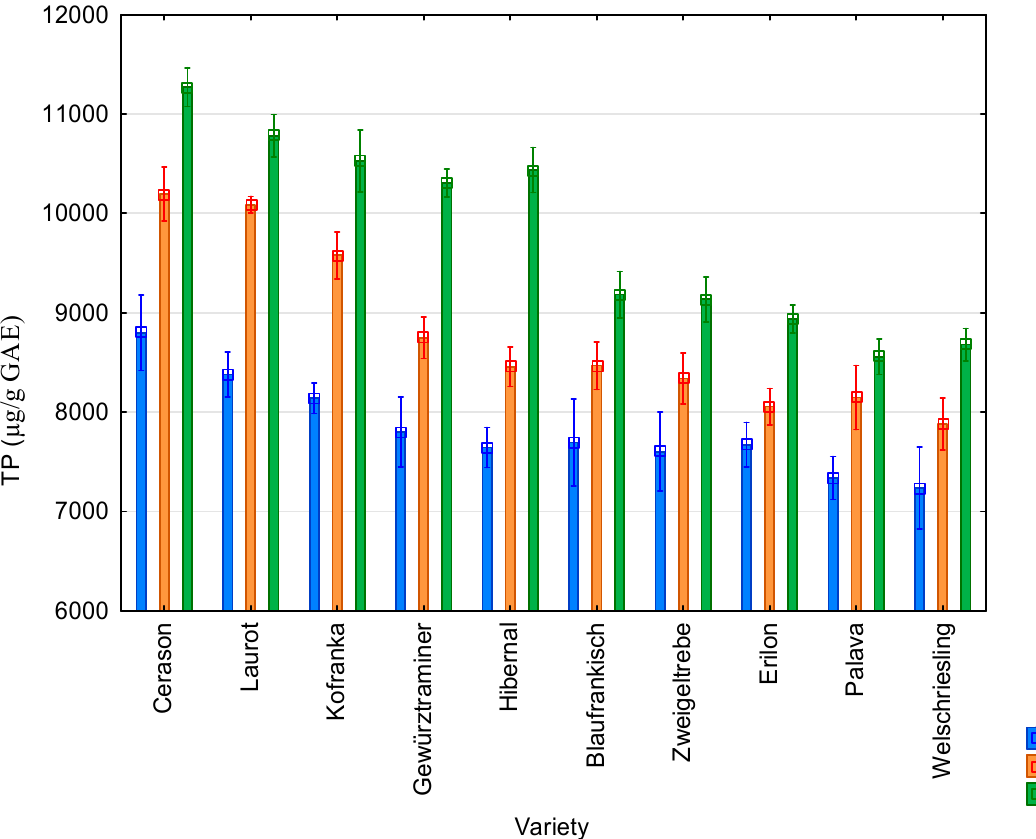
Figure 5. Values of the content of total polyphenolic compounds (TP) for individual vine varieties in 2015 (blue bars), 2016 (orange bars), and 2017 (green bars). 2015: p < 0.01, 2016: p < 0.01, 2017: p < 0.01. The Pearson correlation coefficient was used to measure the strength of a linear association between two methods for each year. The value r = 1 means a perfect positive correlation and the value r = − 1 means a perfect negative correlation. Results are shown in Table 1. Table 1. Pearson correlation coefficient between two methods for determination of antioxidant activity and concentration of total polyphenols.